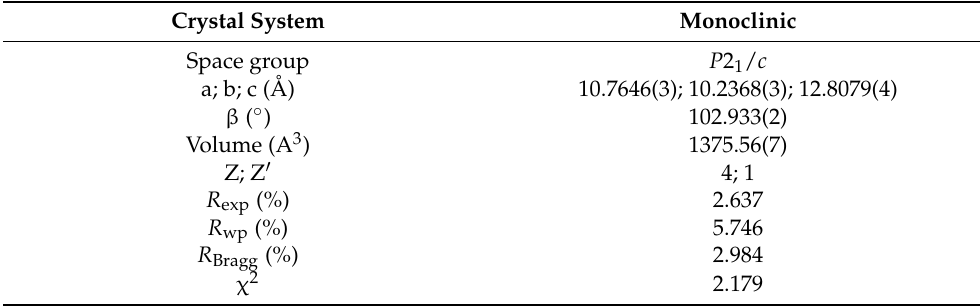
Table 5. Crystal structure of CIP determined via PXRD and statistical information of the Rietveld